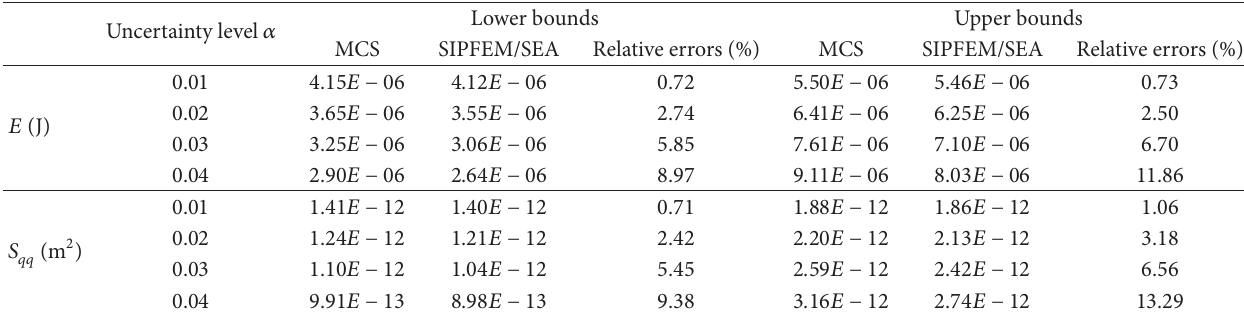
Table 1: The relative errors of the bounds of the plate energy and the autospectrum of the mass displacements for different uncertainty levels ( 𝑓 = 170 Hz).